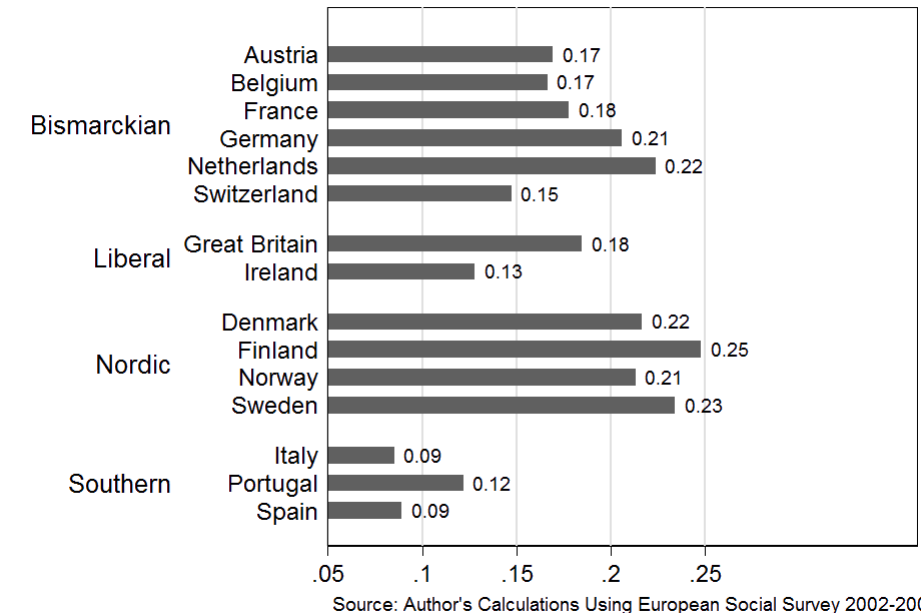
Figure 1: Proportion of Working Age Adults Reporting